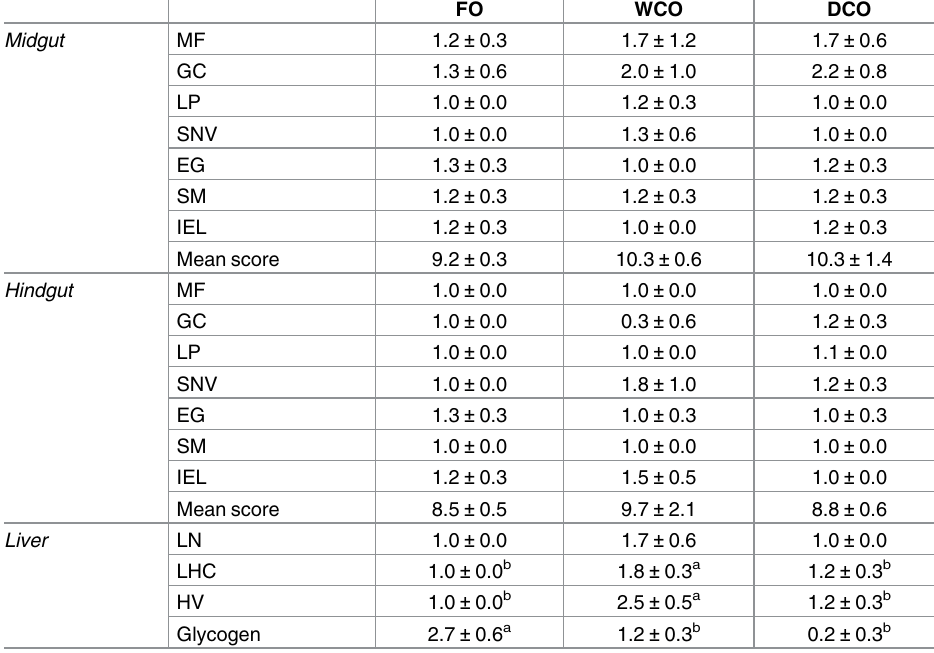
DCO, feed containing EPA+DHA oil from transgenic Camelina; EG, eosinophilic granulocytes; FO, fish oil feed; GC, goblet cells; HV, hepatic vacuolation; IEL, intraepithelial lymphocytes; LHC, liver hepatocyte cytoplasm; LN, liver nuclei; LP, lamina propria; MF, mucosal folds; SM, sub-epithelial mucosa; SNV, supranuclear vacuoles; WCO, wild-type camelina oil